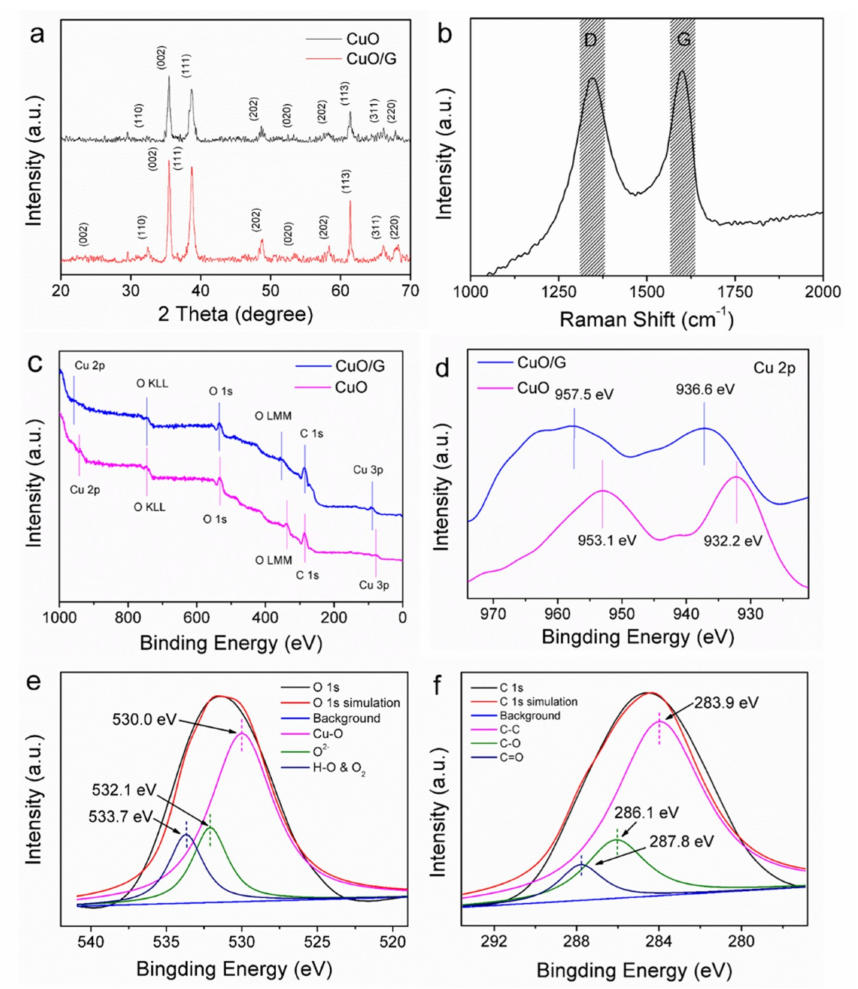
Figure 2. ( a ) X-ray diffraction patterns of CuO and CuO/G. ( b ) Raman spectrum of CuO/G. ( c ) XPS survey spectra of CuO and CuO/G, ( d ) Cu 2p spectra of CuO and CuO/G, O 1s ( e ) and C 1s ( f ) spectra of